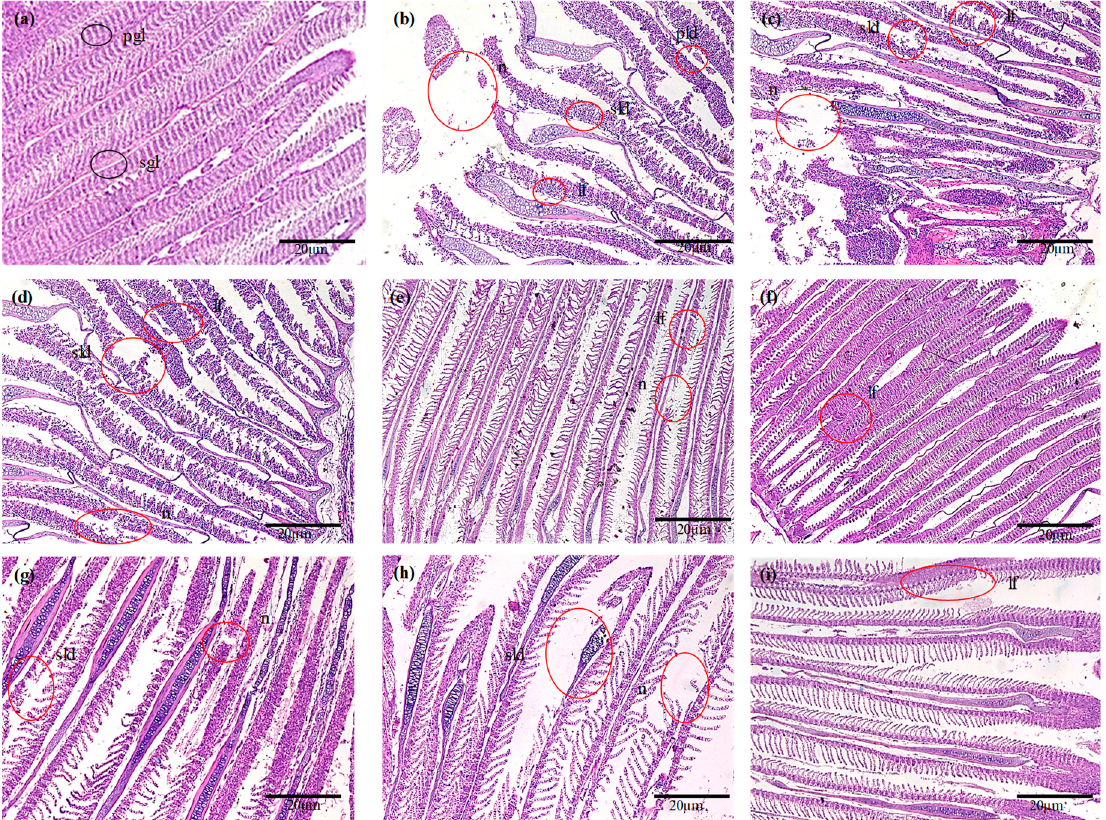
Figure 4. Comparative histological images of gills of the common carp C. carpio from the different experimental exposures. ( a ) Regular gill morphology of carps from the control negative group; ( b ) Gills of carps from the control positive group exposed to 1.5 mg/L of CuO; ( c ) Gills of carps from the control positive group exposed to 1.5 mg/L of Cu-NPs; ( d – f ) Gills of carps exposed to 1.5 mg/L of CuO in addition to MSFE administrated at 4 mg/L ( d ), 8 mg/L ( e ) and 12 mg/L ( f ); ( g – i ) Gills of carps exposed to 1.5 mg/L of Cu-NPs in addition to MSFE administrated at 4 mg/L ( g ), 8 mg/L ( h ) and 12 mg/L ( i ). Overall, it is possible to notice the primary gill lamellae (pgl), secondary gill lamellae (sgl), secondary lamellar degeneration (sld), primary lamellar degeneration (pln), lamellar fusion (lf), and necrosis (n). The scale bar represents 20 µ m; five fields of one histological section per sample were analyzed. (H&E; 200 ×